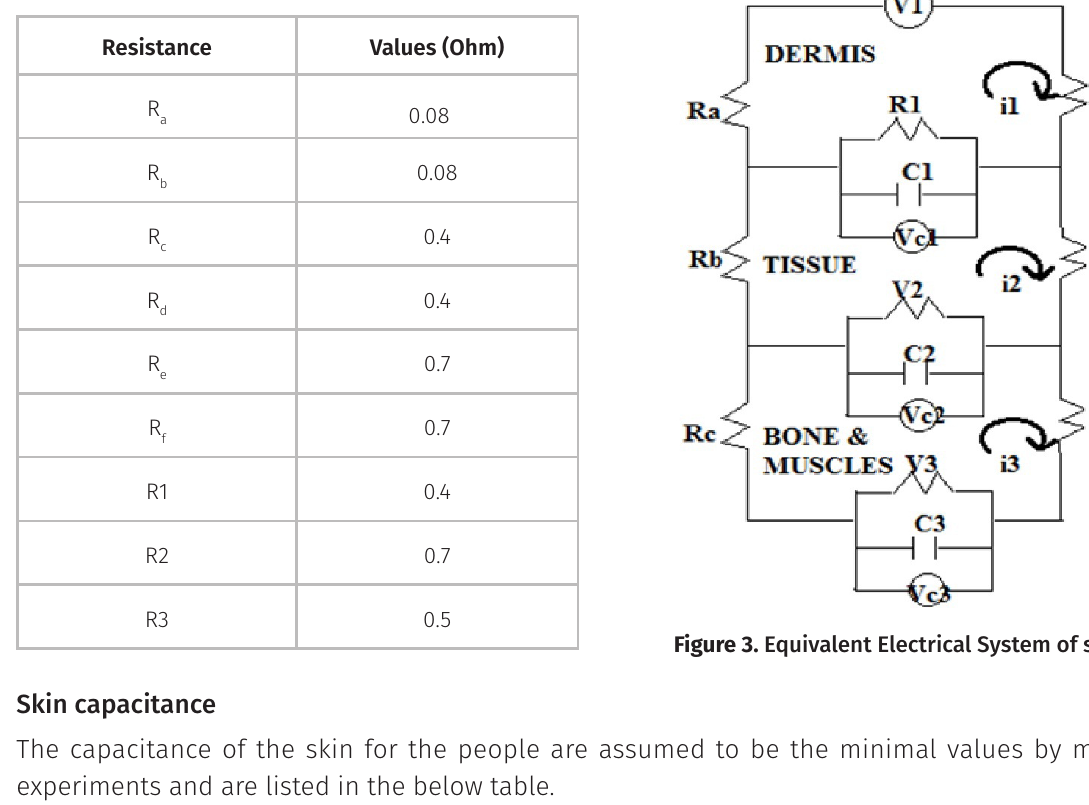
Table I. Resistance of the